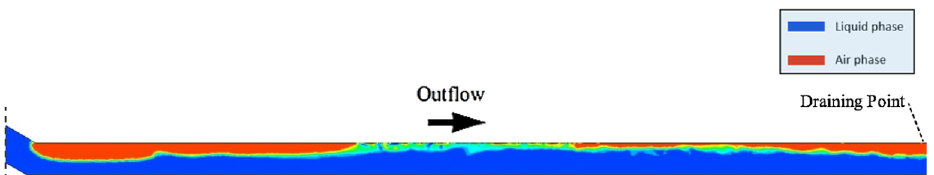
Figure 11. Inception and progression of backflow air intrusion in Scenario B.